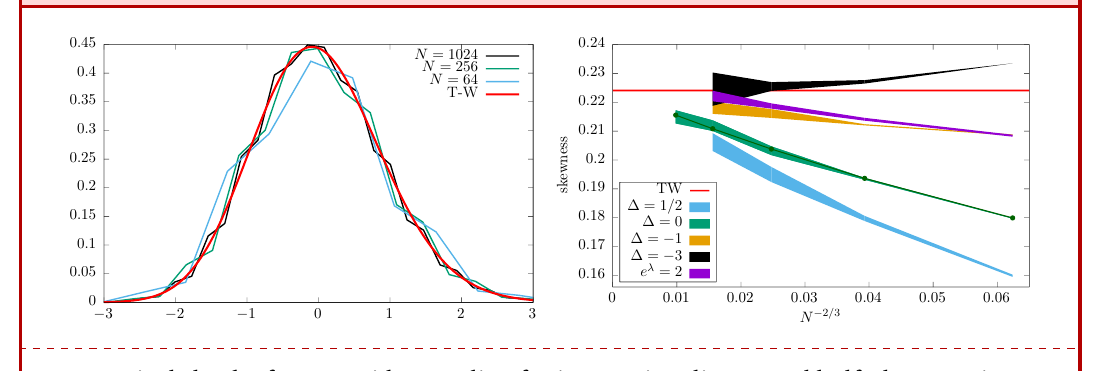
Figure 19: Tracy-Widom scaling with